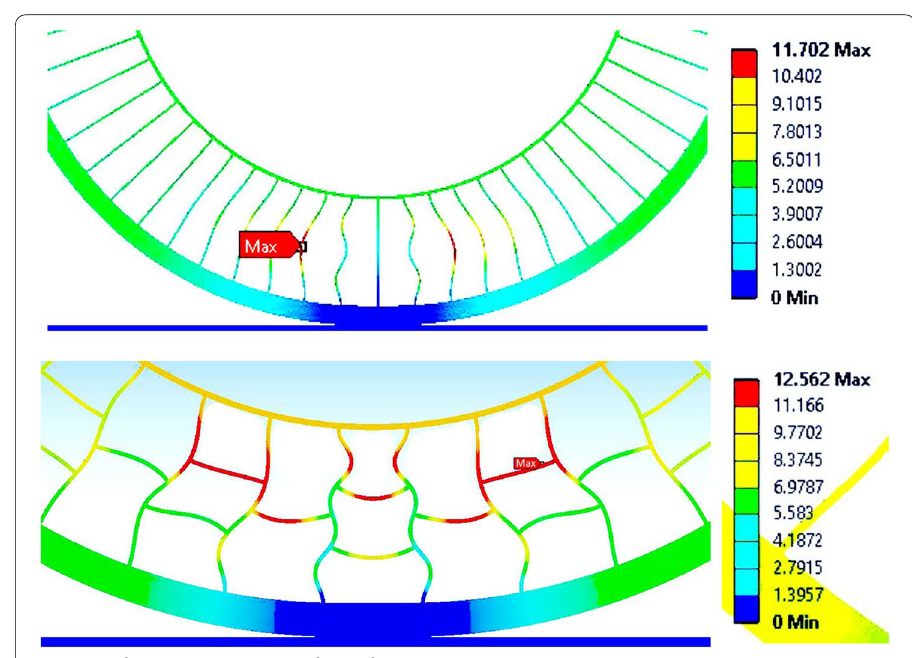
Fig. 15 Deformation contours at a force of 2500 N